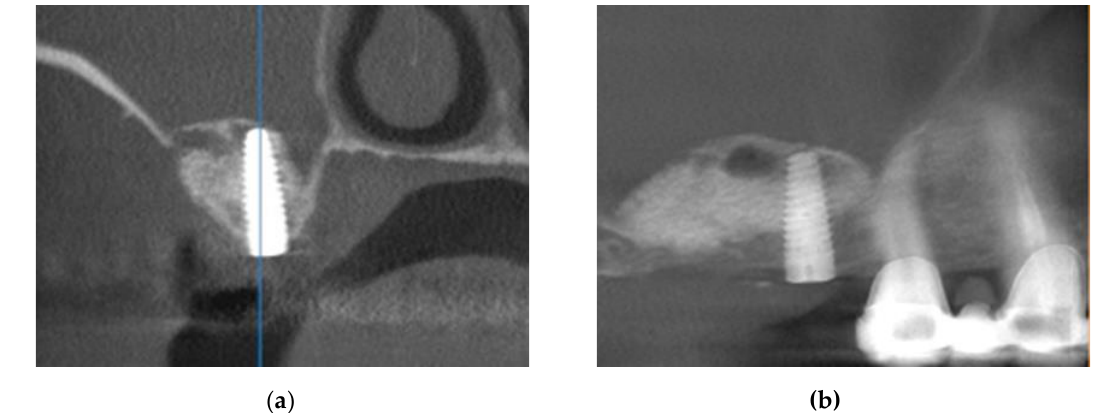
Figure 6. ( a ) Postoperative control of the patient using 3D imaging; ( b ) the augmented 17 site (cross-sections).